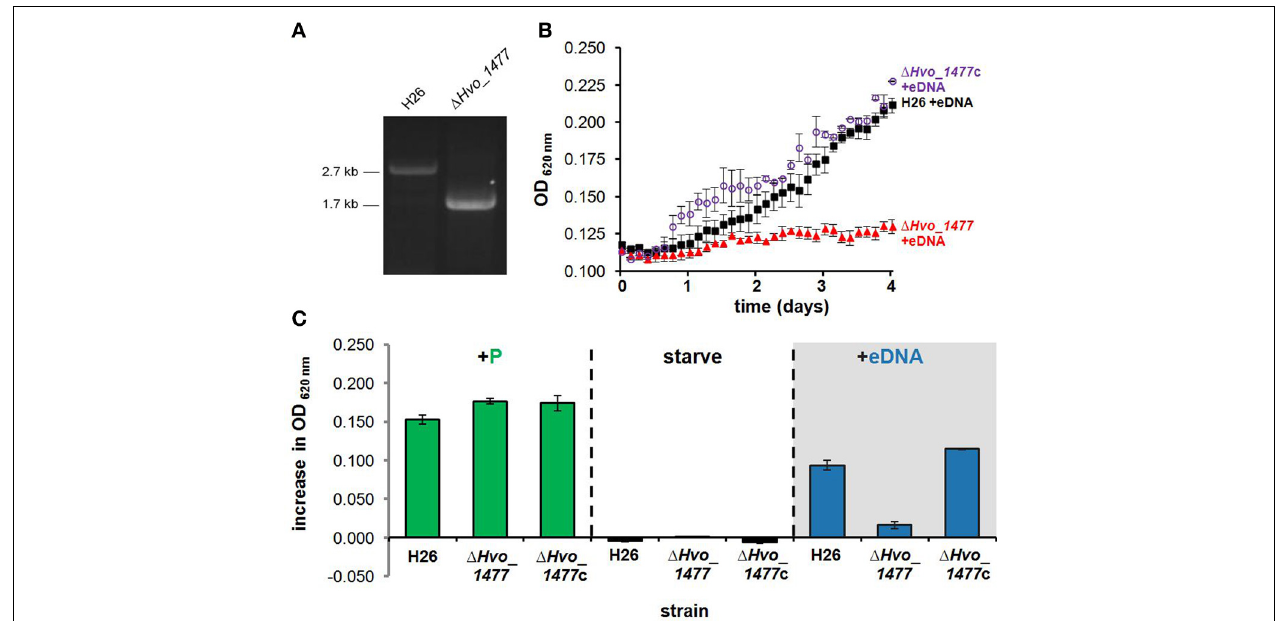
FIGURE 7 | Hvo_1477 is required for growth on DNA. (A) Deletion of chromosomal gene Hvo_1477 in H. volcanii strain H26. PCR amplification of H26 and (cid:2) Hvo_1477 template DNA using the forward primer for the upstream Hvo_1477 flanking region, and the reverse primer of the downstream flanking region (Hvo_1477FR1_F and Hvo_1477FR2_R, Table 3 ). (B) Growth with eDNA in CN media for H26 (parental strain,